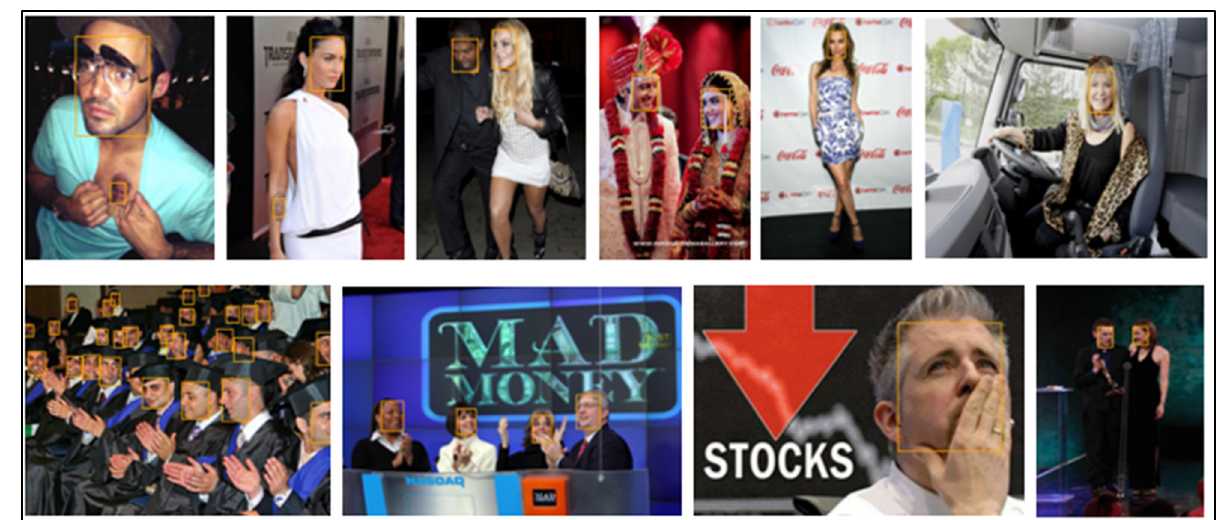
Figure 4. Makeup image results (WIDER FACE dataset).